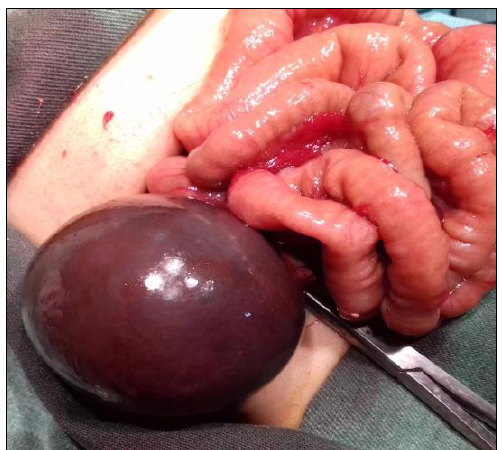
Figure 1: Cystic structure found on the exploration of the abdomen The patient was prepared for surgery and on explora- tion, a discolored, necrotic cyst was immediately apparent (Fig.1). This was free of a vascular pedicle and firmly attached to a segment of the terminal small bowel which was obstructed (Fig.2). Her uterus and left ovary were normal, but the right ovary was not evident. This mass was presumed to be an auto- amputated cyst arising from the right ovary and once freed from the ileum, was excised. The patency of